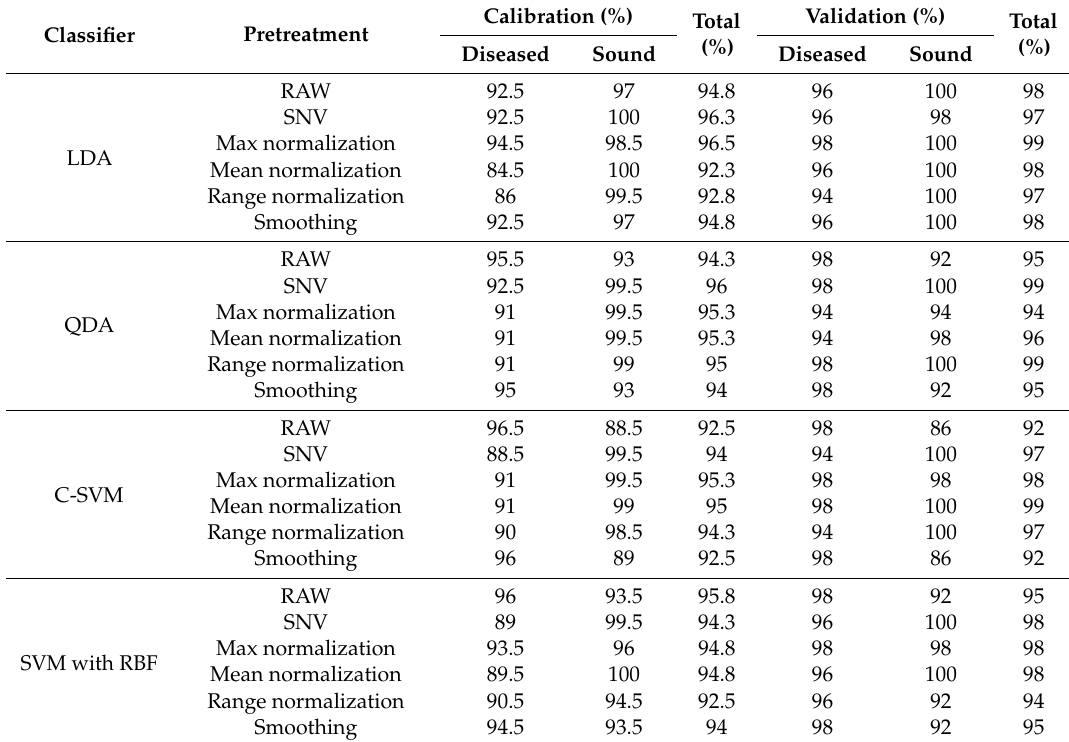
Table 3. Calibration and validation results of each classifier with different pretreatment methods using two subset wavelengths for diseased and sound rice seed.